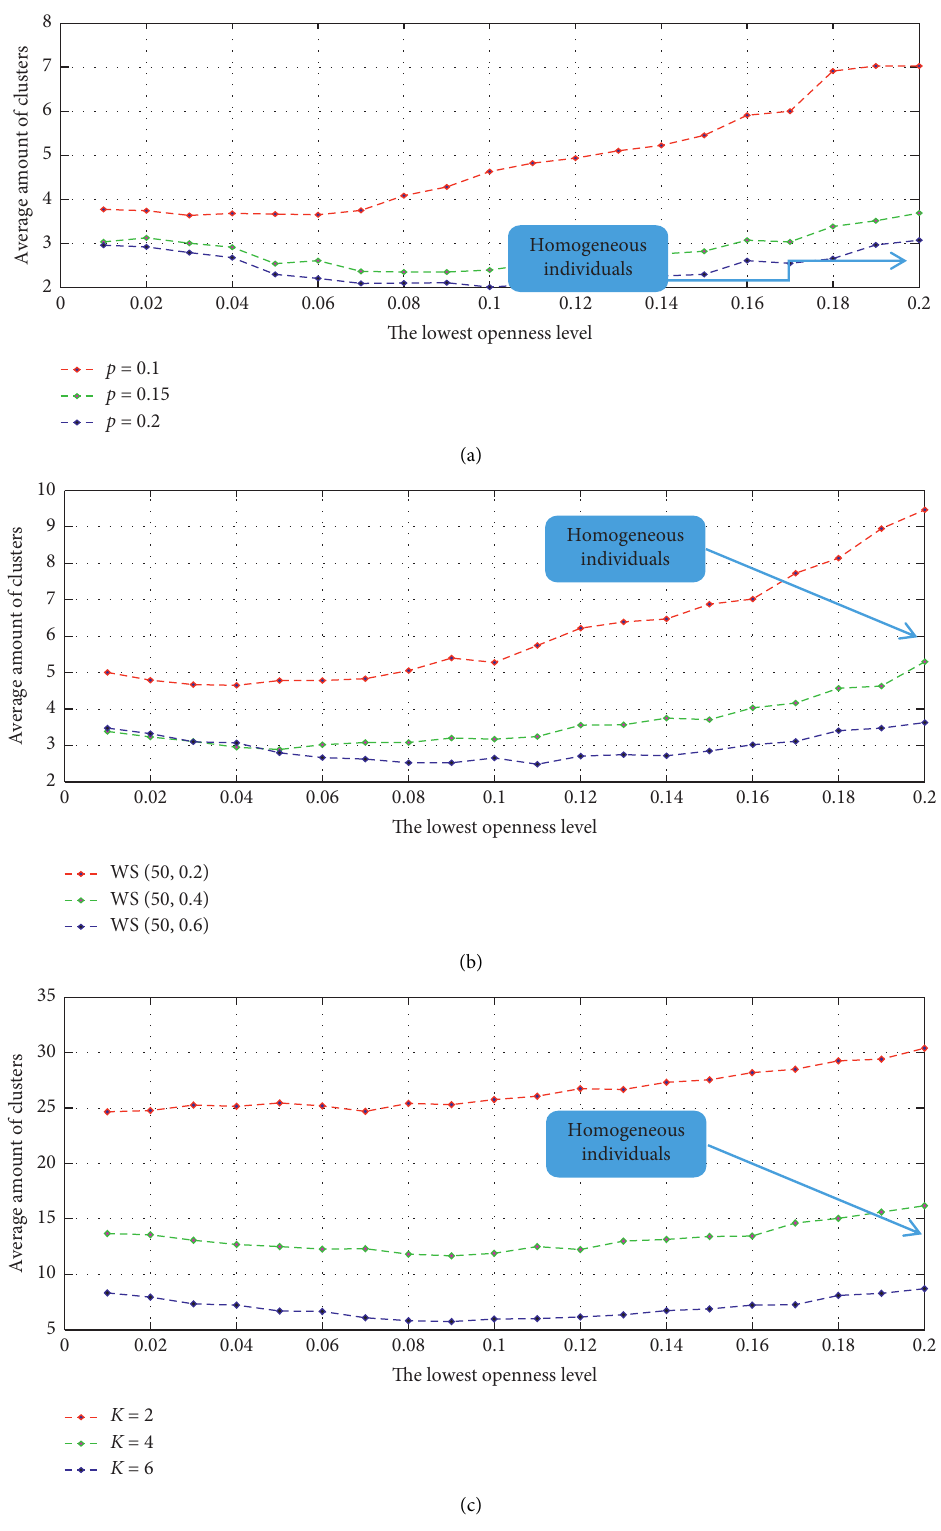
Figure 2: Influence of heterogeneity on AOC under different network